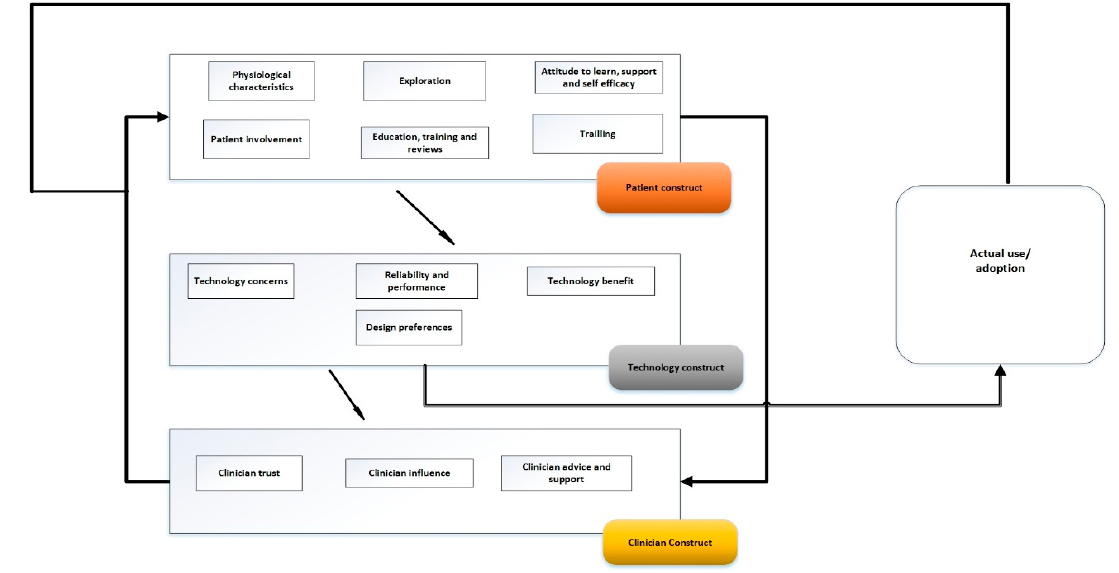
Figure 2. Senior Patients Technology Acceptance Model (SPTAM).